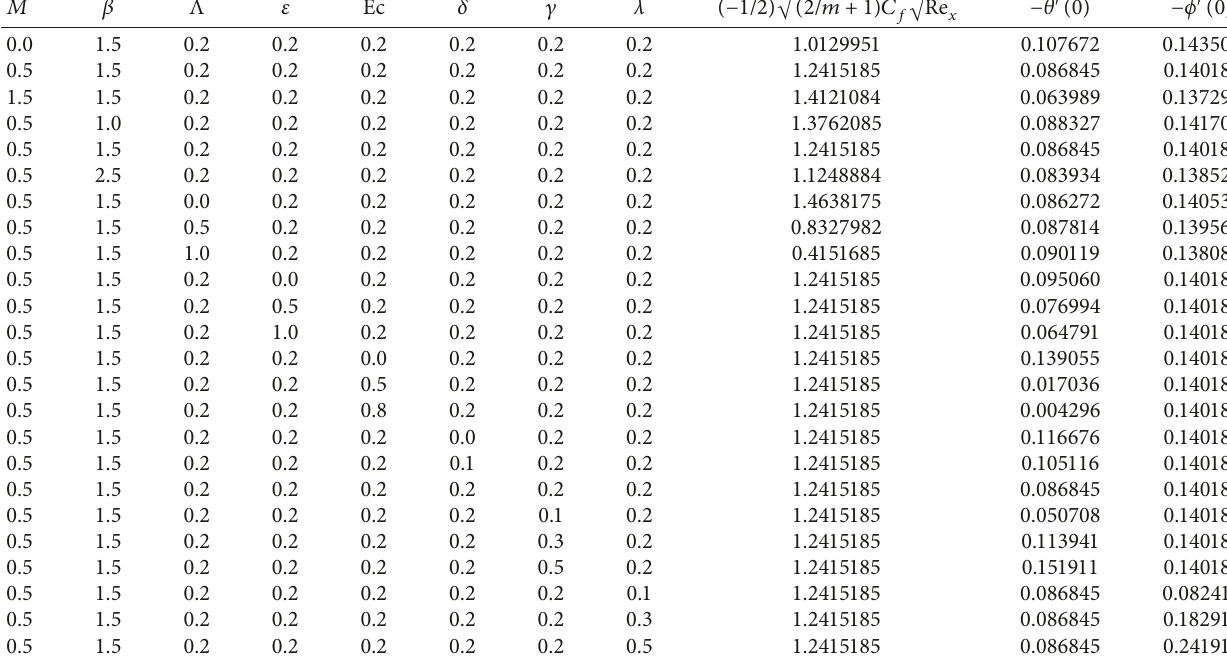
Table 2: Variation of ( 1/2 ) and Sc � 0 .